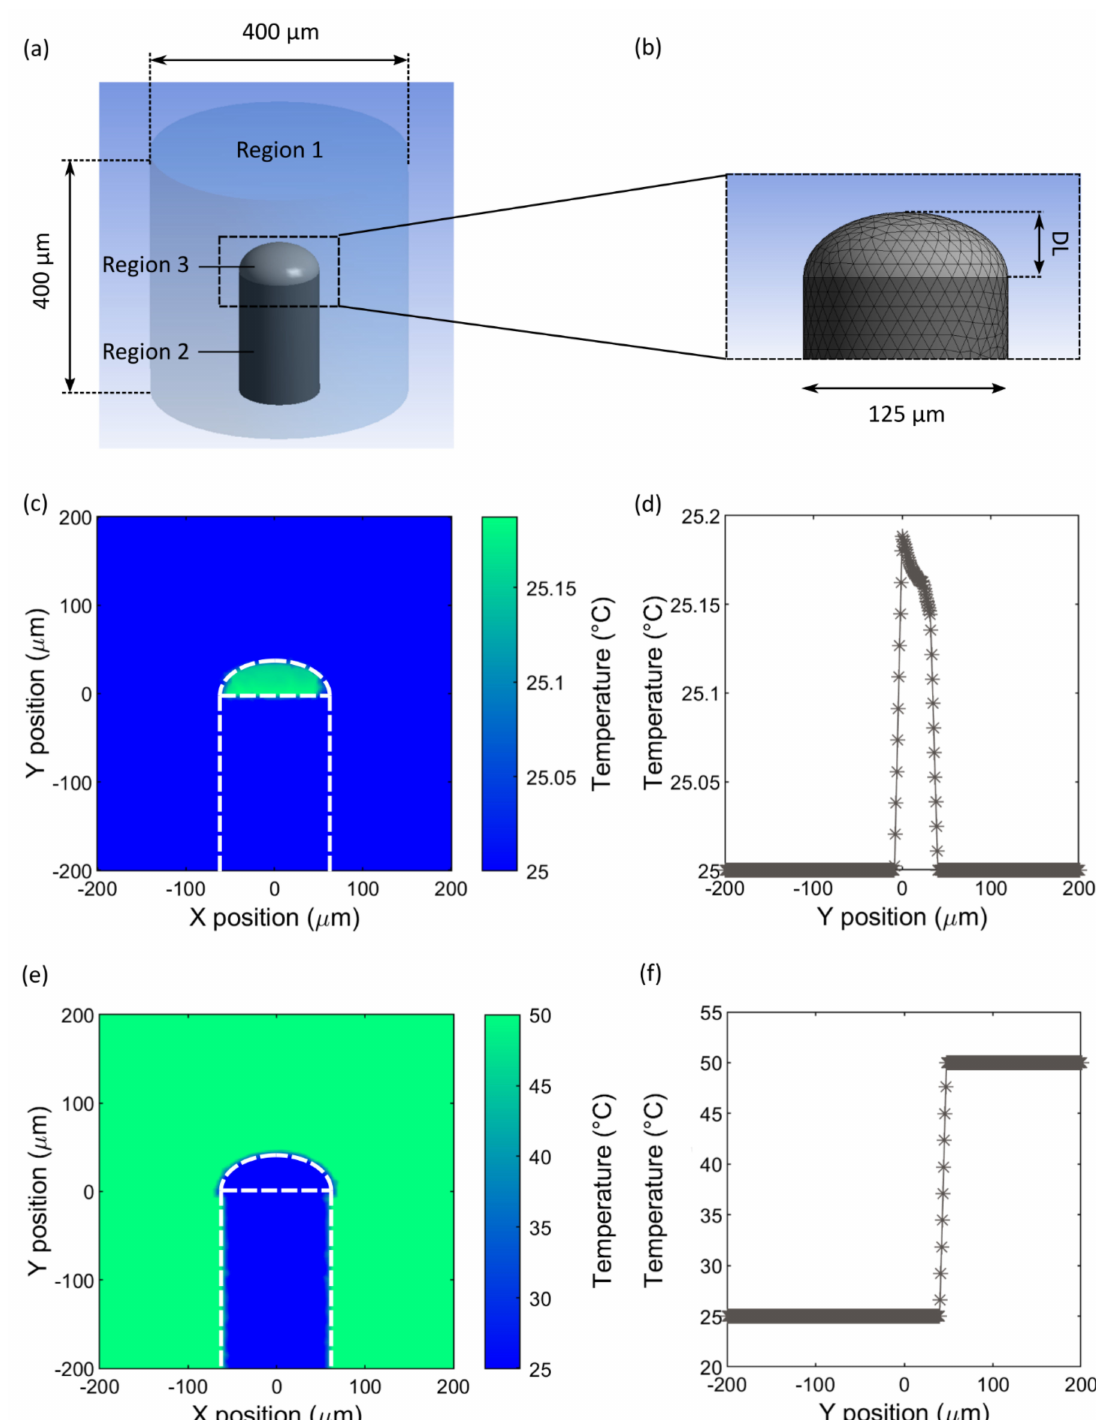
Figure 4. ( a ) Finite element (FE) model geometry; Region 1: surrounding medium (water), Region 2: optical fibre (fused silica); Region 3: PDMS dome. ( b ) Enlarged section of the finite element mesh (surrounding medium not shown), in the area indicated by the dotted box in ( a ); DL: dome length. ( c ) Initial temperature distribution for the FE model in the x-y plane at z = 0, for the optical heating case; DL = 32 µ m. ( d ) Initial temperature versus y -axis position for the optical heating case. ( e ) Initial temperature distribution for the FE model in the x-y plane at z = 0, for the temperature step case; DL = 40 µ m. In ( c , e ), the white dashed lines indicate the boundaries of the fibre and dome regions. ( f ) Initial temperature distribution versus y -axis position for the temperature step